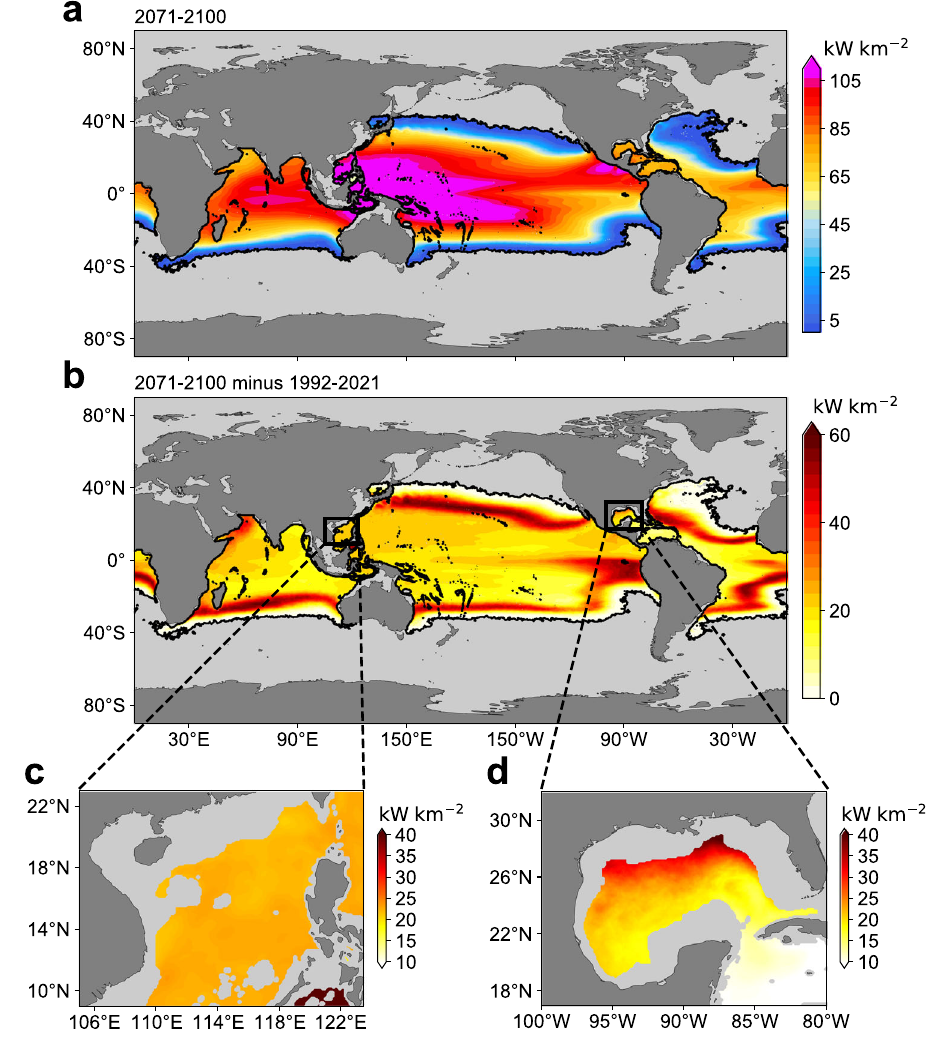
Fig.2|Projectedchangeofoceanthermalenergyconversion(OTEC)resources under a high carbon emission scenario by the high-resolution Community Earth System Model (CESM-H). Geographic distribution of time-mean OTEC